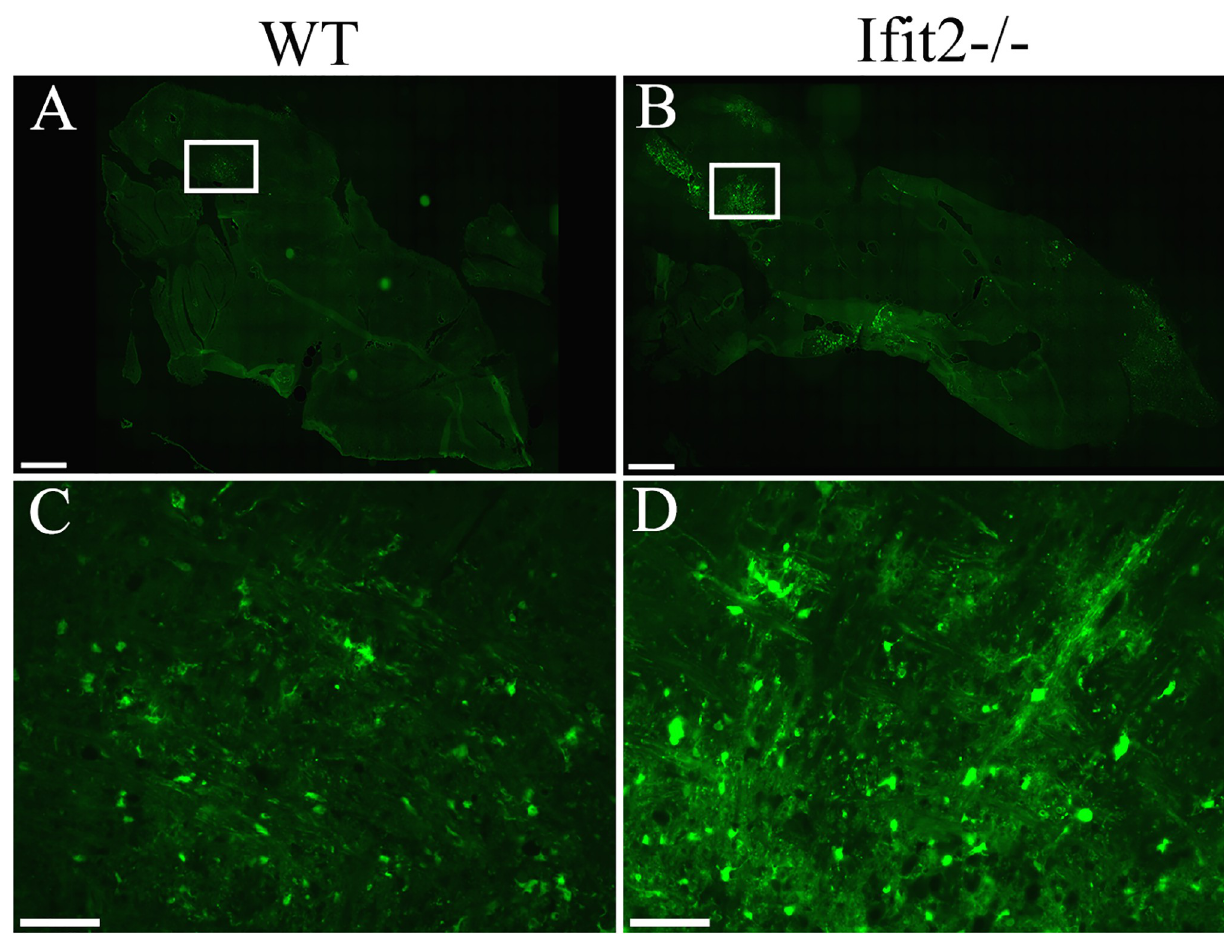
Fig 2. Ifit2 deficiency increases RSA59 viral spread throughout the brain parenchyma. 5–10 μ m thin cryosections were prepared from brains of 4–5 weeks old WT and Ifit2 -/- infected mice at day 5 p.i. Representative EGFP fluorescence in whole brain section is shown from WT (A; n = 2) and Ifit2 -/- (B; n = 4) mice. Similar anatomic locations from the WT and Ifit2-/- mice brain stem regions were magnified for both WT (C) and Ifit2 -/- (D) infected mice. Scale bar for Panels A and B = 1mm and for Panel C and D = 50 μ m.